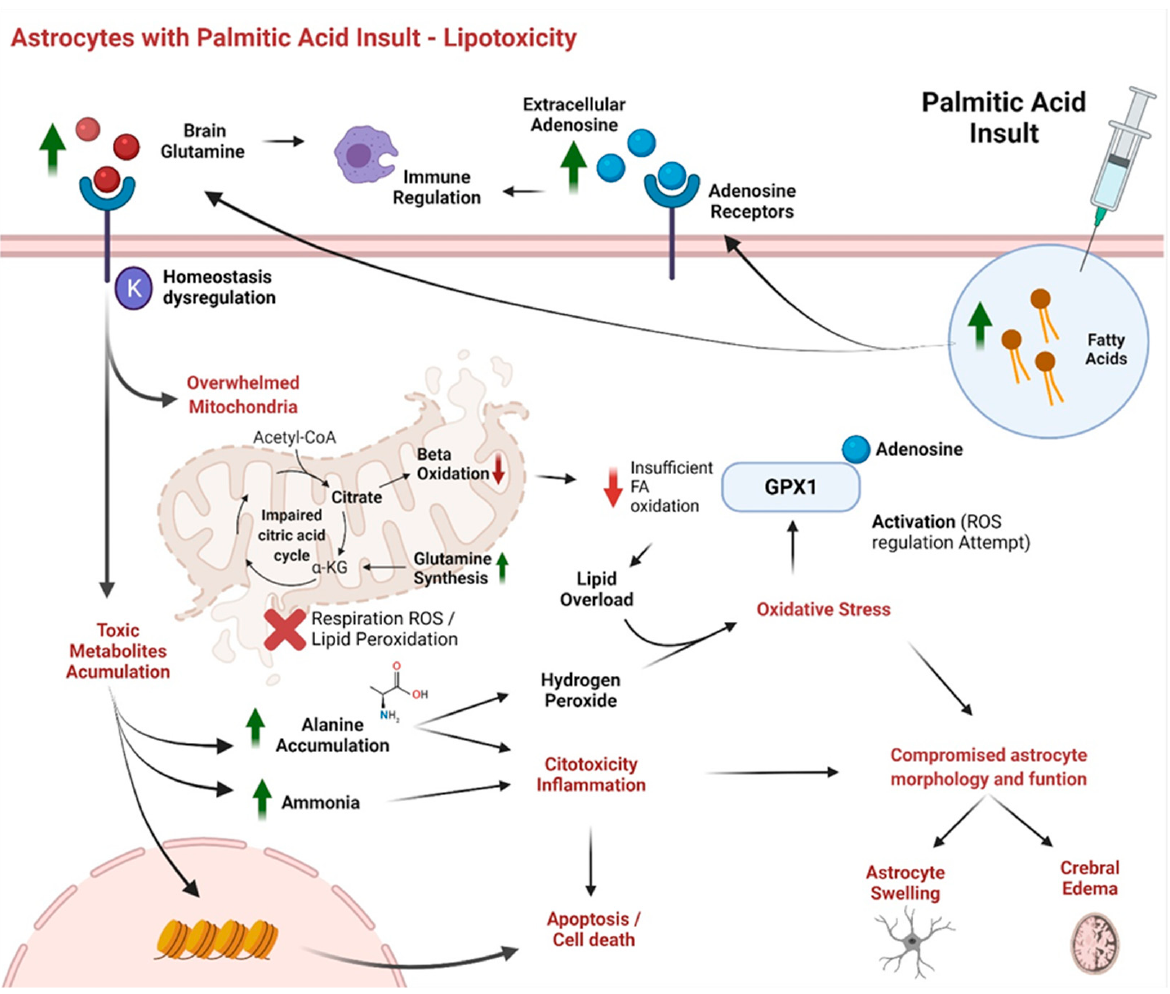
Figure 4. Metabolites and pathways with biomarker potential for lipotoxicity induced by palmitic acid in human astrocytes. Accumulation of alanine, adenosine, citric acid, and glutamine are pro- posed as biomarkers for lipotoxicity in human astrocytes. Principal pathways involved comprise seleno-amino acid compounds, glutamine and glutamate metabolism, the citric acid cycle, the urea cycle, and alanine and adenosine metabolism. The figure highlights their potential activities in as- trocyte metabolism and the consequences of dysregulation of the mentioned metabolites, resulting in scenarios related to lipotoxicity such as cytotoxicity, inflammation, apoptosis or cell death, astro- cyte swelling, and cerebral edema.